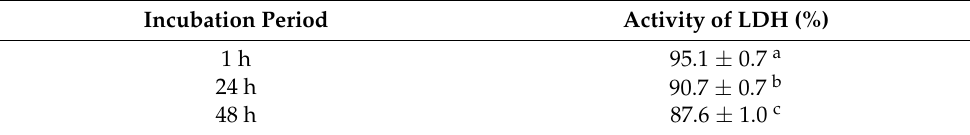
Table 1. Activity of lactate dehydrogenase (LDH) at 1, 24 and 48 h of explant incubation, as an indicator of explant viability. Since damaged cells release LDH extracellularly, the viability was measured by the calculation of quotient of the intracellular LDH activity and the total activity (extracellular plus intracellular LDH). Data are shown as means ± SEM. Statistical differences between times of incubation are signaled by different superscript letters (a,b and b,c: p < 0.05; a,c: p < 0.01).